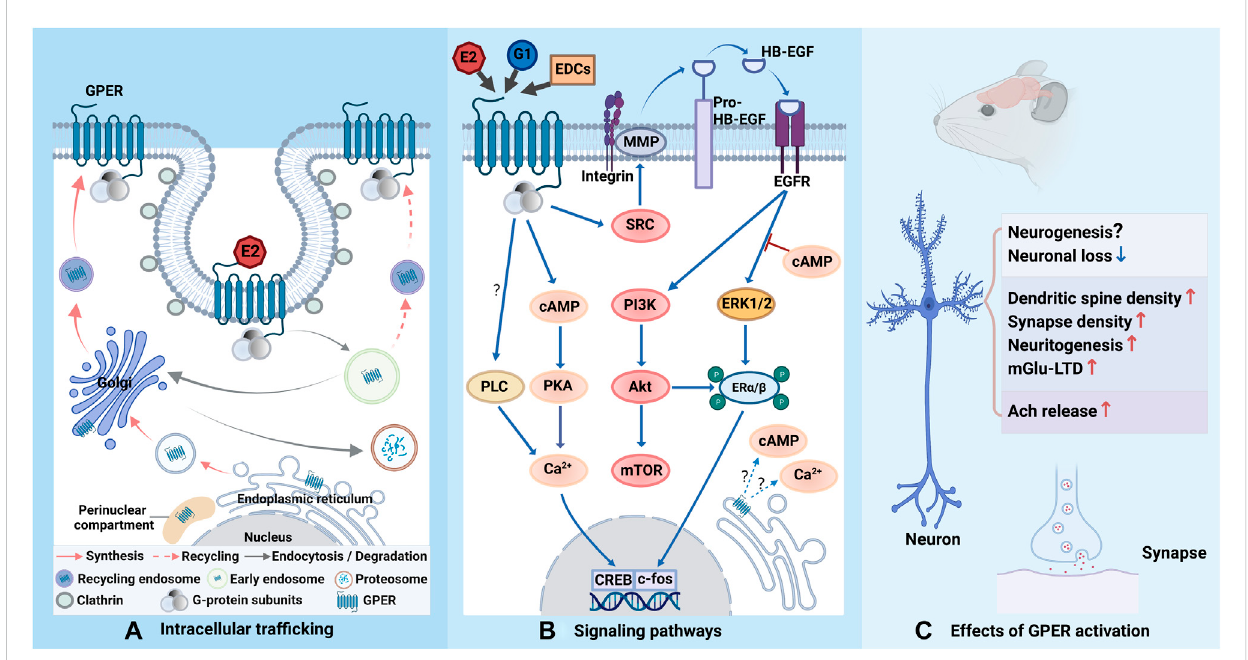
FIGURE 1 Schematic representation of GPER traf fi cking, related signaling pathways and effects. (A) GPER is biosynthesized in the endoplasmic reticulum and processed in the Golgi apparatus before its traf fi cking to the plasma membrane. When binding to estrogen or estrogen-like molecules, GPER is constitutively endocytosed into cells via clathrin-coated vesicles and enters the early endosome. The majority of GPERs are transported to the Golgi apparatus and degraded via the ubiquitin-proteasomal system, while a minority of them are recycled back to the cell membrane. GPER is also reported to accumulate in the perinuclear compartment. (B) Upon activation, the G protein departs into G α and G βγ subunits and further triggers complicated signaling cascades. G βγ stimulates SRC-activated MMPs, leading to the release of HB-EGF from the cell surface, which transactivates EGFR and subsequently triggers ERK1/2 and PI3K. G α s activates AC and increases cAMP generation, which results in intracellular calcium mobilization. cAMP also recruits PKA to activates CREB in the nucleus to initiate transcription, which can also be potentiated by phosphorylated ER α / β via ERK and Akt. The cAMP-relatedsignaling pathwaycanregulateEGFR-inducedERK1/2activity.ItisnotyetclearwhetherGPERsignaling canbeobservedfromintracellular receptors. The involvement of PLC may depend on cell type (question marks). (C) Activation of GPER can exert neuroprotection to reduce neuronal loss, but the role of GPER in neurogenesis necessities further investigation. Activation of GPER can positively regulate synaptic formation and plasticity.